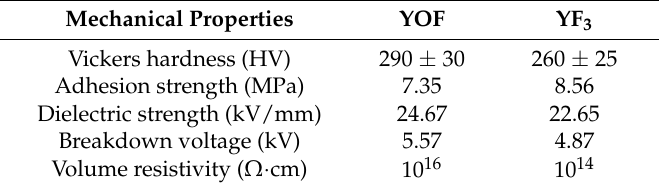
Table 3. Mechanical and electrical properties of YOF and YF 3